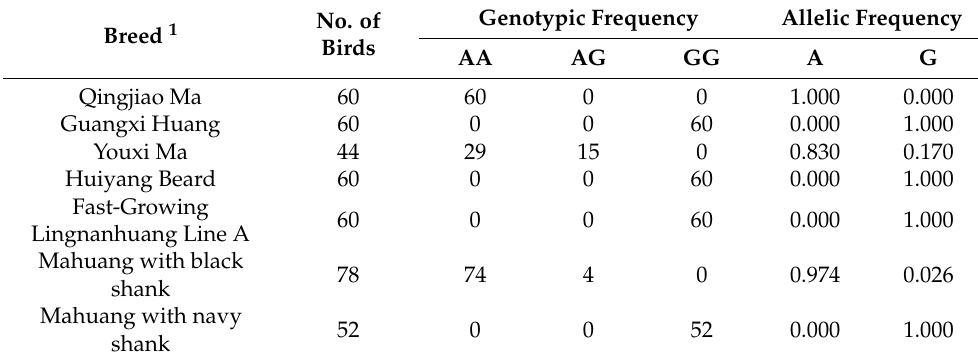
Table 3. Allelic frequencies for the SNP c.890A>G in the BCO2 gene in 7 chicken breeds. Breed